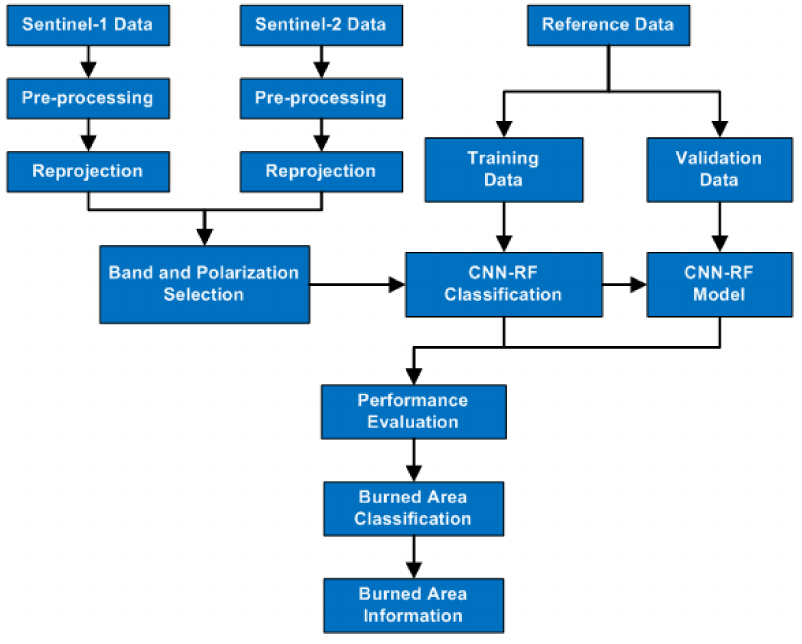
Figure 3. Research workflow.